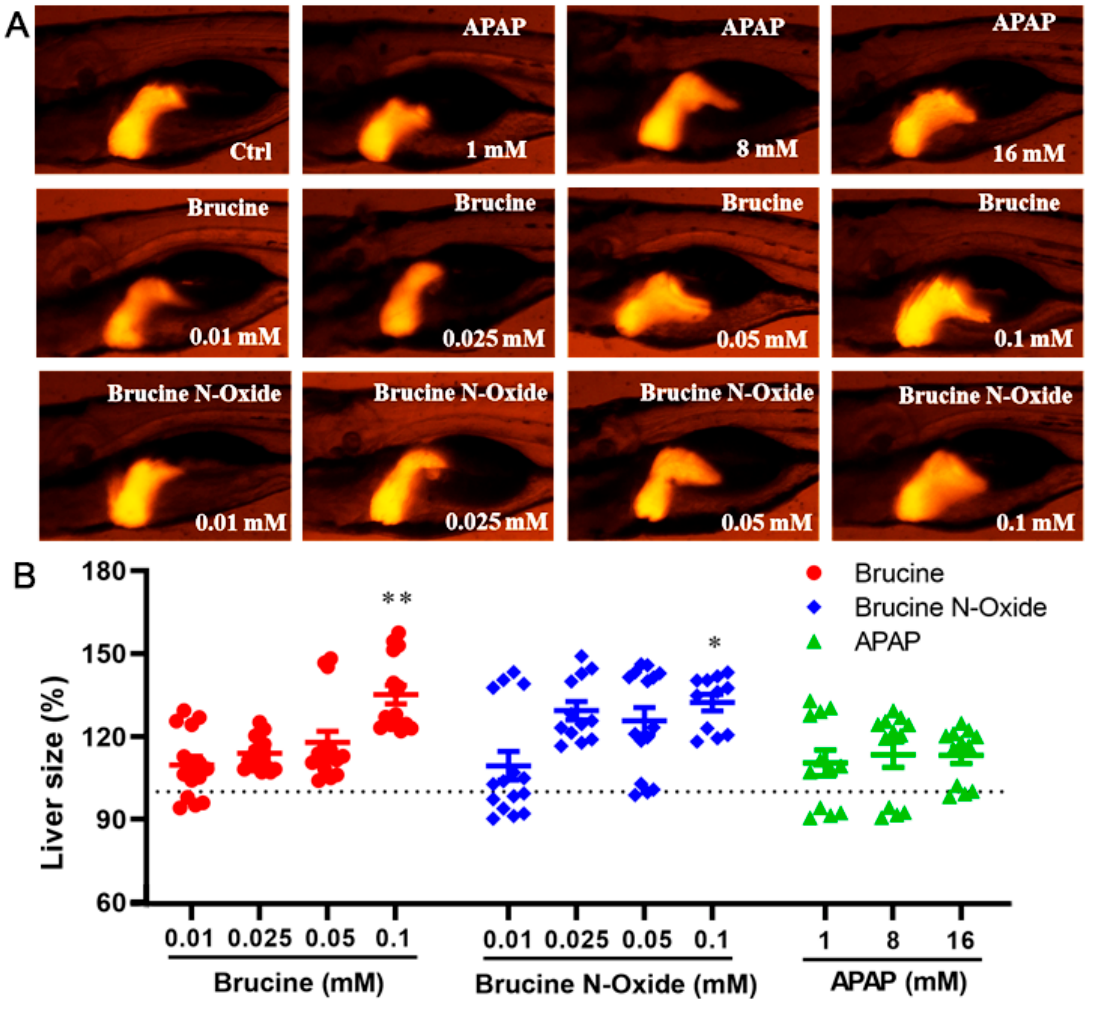
Figure 3. Effects of BRU and BNO on liver development in transgenic zebrafish. ( A ) Abnormal phe- notypes caused by BRU, BNO and APAP on transgenic zebrafish, ( B ) Comparison of toxicity of BRU, BNO and APAP in transgenic zebrafish. Values represent the mean ± SEM (n = 20), * p < 0.05, ** p < 0.01